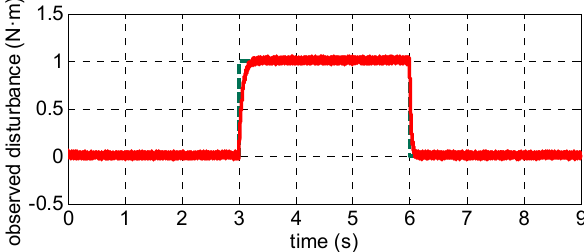
Figure 19. Experimental curves of observations based on the ESMO for a step disturbance of 1 N ∙ m.